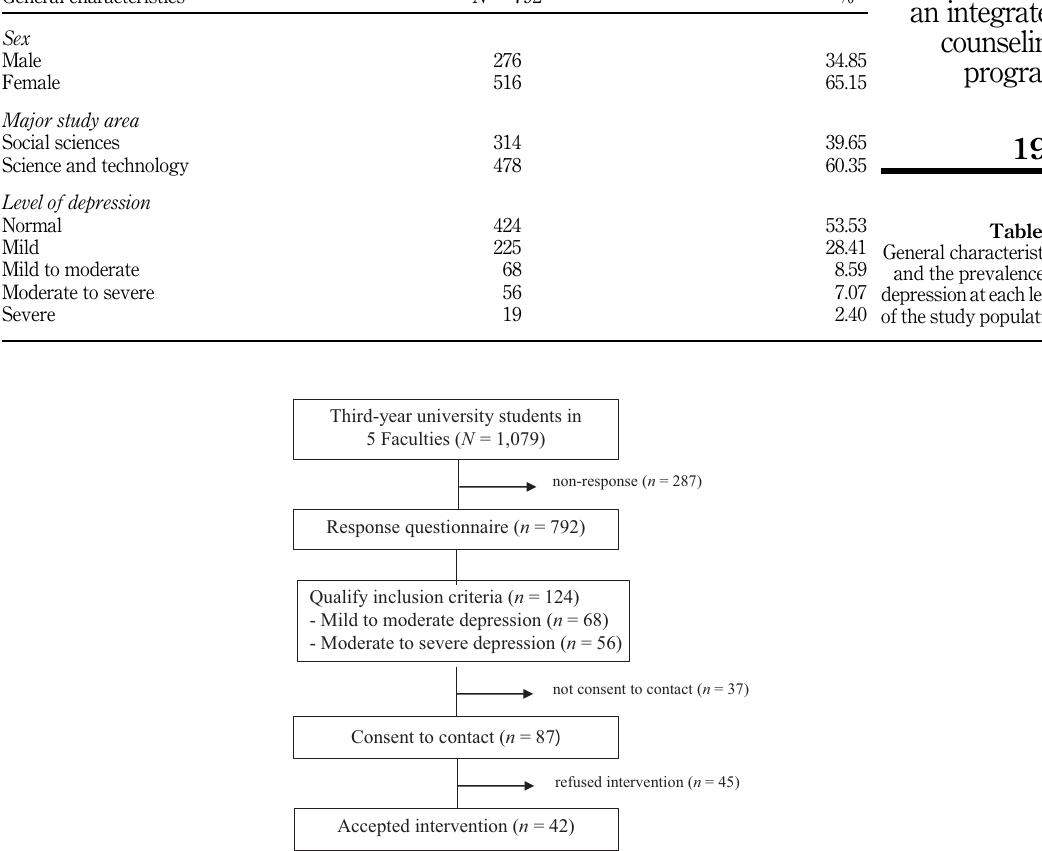
Figure 1. Flow diagram of the enrollment of subjects, allocation to the counseling program and disposition status inPhaseIIofthisstudy Table 4. The differences in the ER and depressive mean scores between before and after counseling in the experiment group ( n 5